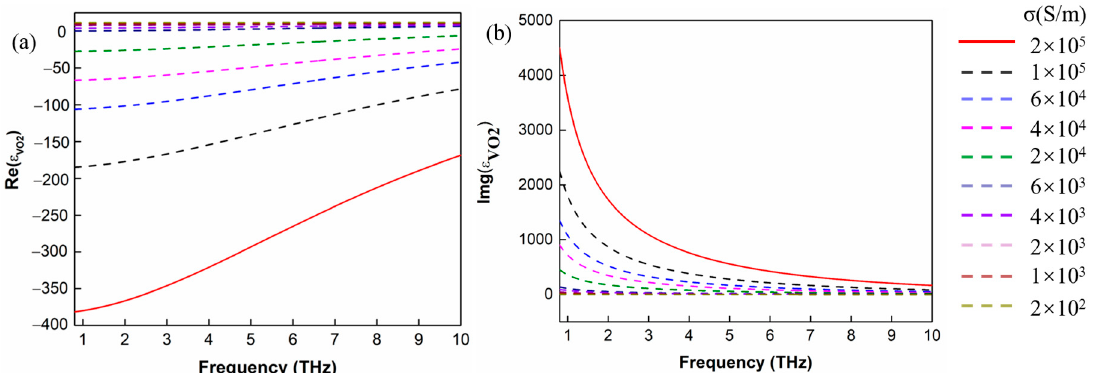
Figure 4. Change of dielectric constant of VO 2 under different conductivities in ( a ) the real part and ( b ) the imaginary part.